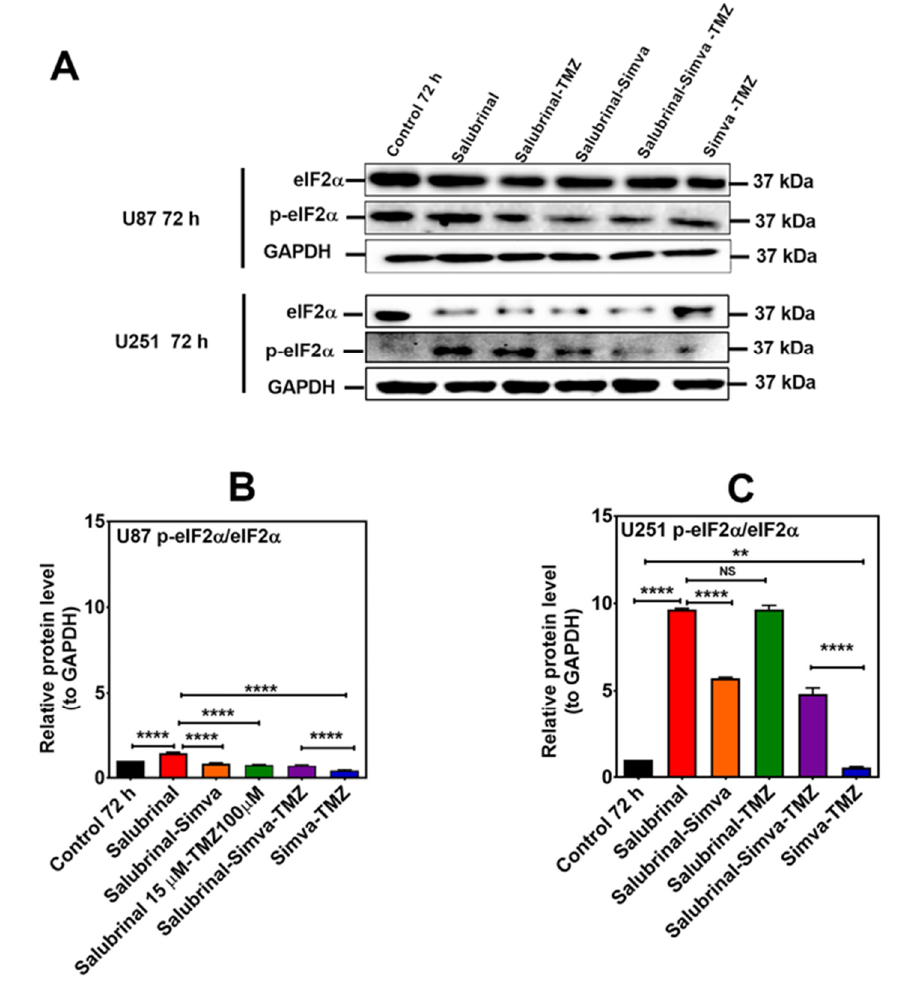
Figure 9. p-eIF2 α phosphatase inhibition increases the p-eIF2 α / eIF2 α ratio in Simva–TMZ treated in GBM cells. ( A ) U87 and U251 cells were pretreated with salubrinal (15 µ M, 30 min) followed by co-treatment with Simva–TMZ for 72 h. Cell lysates were collected, and the p-eIF2 α / eIF2 α protein amount ratios were determined using immunoblotting; GAPDH was used as a loading control. ( B , C ) Densitometric analysis of the Western blot bands shows that salubrinal significantly ( p < 0.0001) increased the p-eIF2 α / eIF2 α ratio with Simva–TMZ treatment. Data are expressed as the means ± SD of three independent experiments (** p < 0.01, **** p < 0.0001).